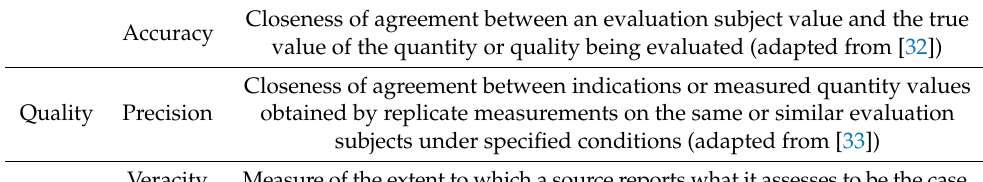
Table 1. URREF Data Criterion: